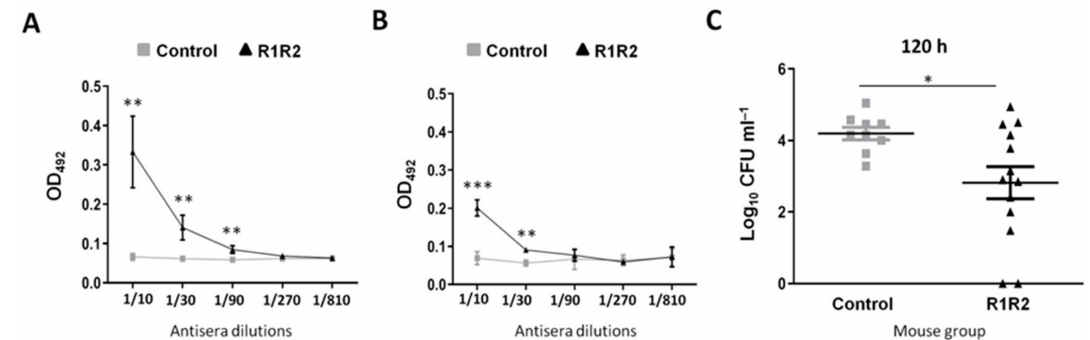
Figure 4. Protection against intranasal colonization. Antibody levels of IgA ( A ) and total IgG ( B ) after immunization with control, or DiiA − R1R2 preparations. Data are expressed as the average and standard deviation of triplicate samples. Bacterial load in nasopharyngeal lavage at 120 h post-colonization in groups of at least nine mice. ( C ). Statistical significance was analyzed by Student’s t-test. * p < 0.05; ** p < 0.01; *** p <